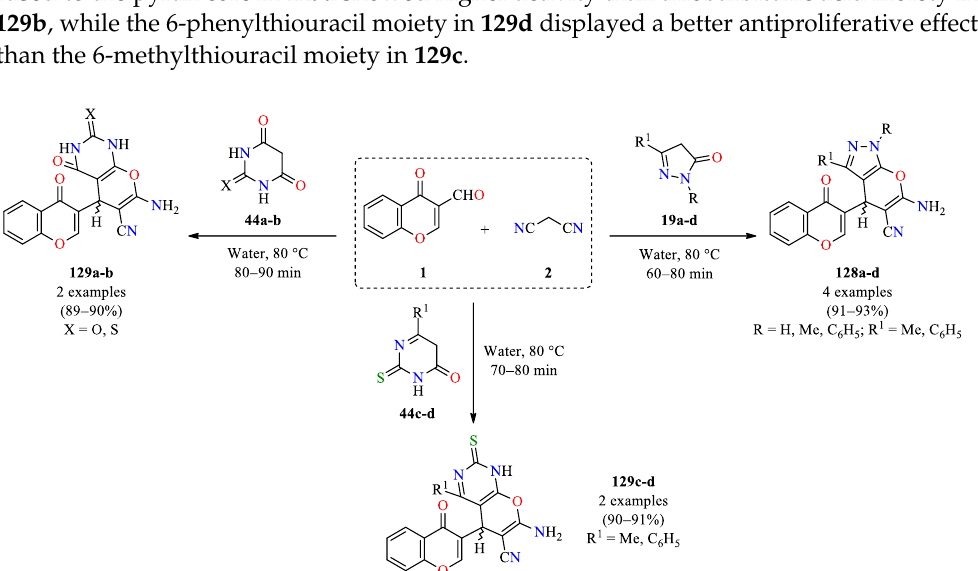
Table 35. Anticancer activity of compounds 128 and 129 against PC-3, SKOV3, and HeLa cell lines.